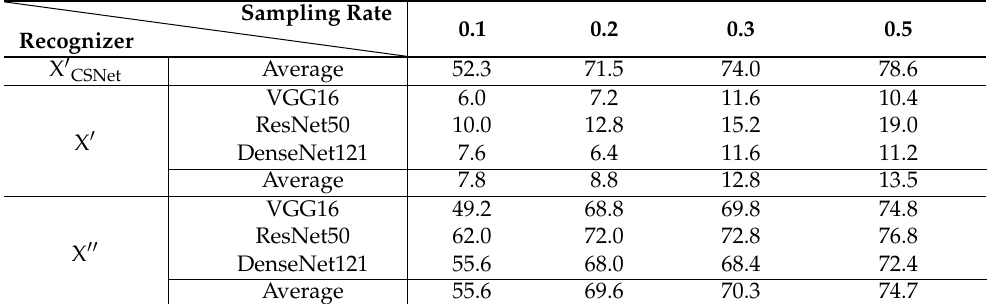
Table 4. Comparing recognition rates of three recognizers for X (cid:48) CSNet , X (cid:48) and X (cid:48)(cid:48) at various sampling rates (%).